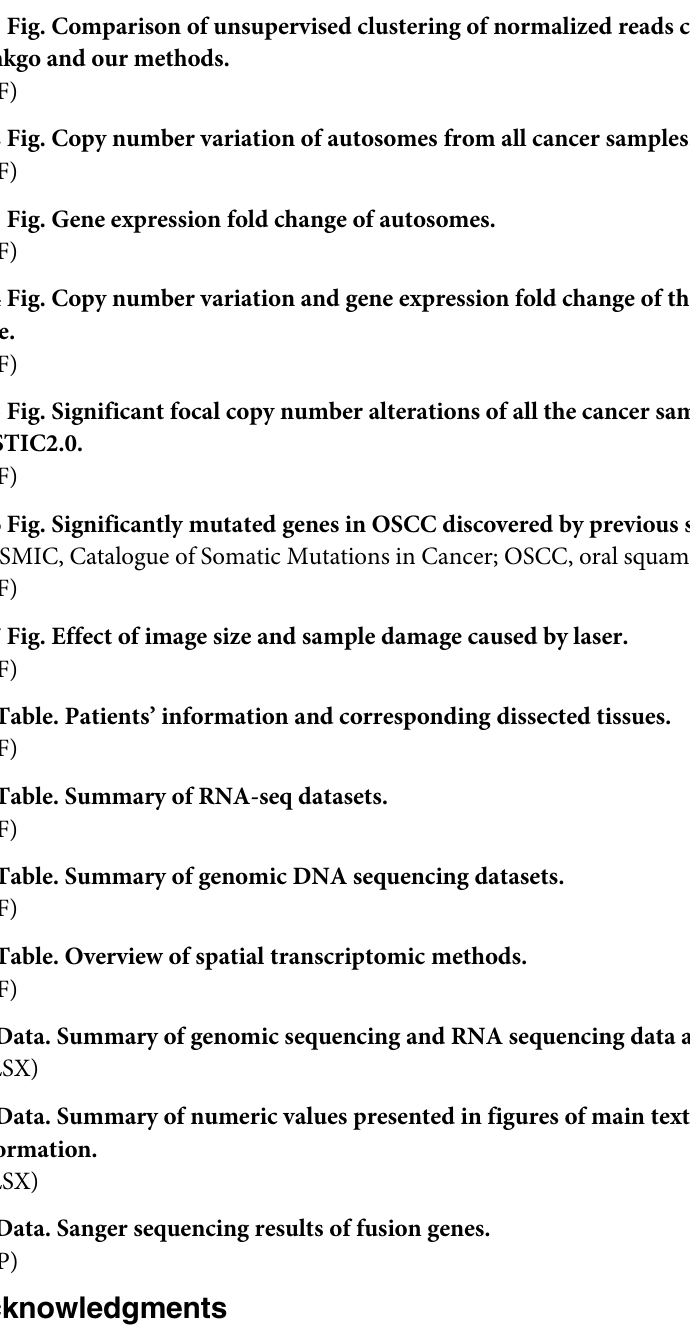
S20 Fig. Genome-wide copy number distribution at different sampling rates. (TIF) S21 Fig. Comparison of unsupervised clustering of normalized reads count between Ginkgo and our methods. (TIF) S22 Fig. Copy number variation of autosomes from all cancer samples. (TIF) S23 Fig. Gene expression fold change of autosomes. (TIF) S24 Fig. Copy number variation and gene expression fold change of the same sectioned slice. (TIF) S25 Fig. Significant focal copy number alterations of all the cancer samples analyzed by GISTIC2.0. (TIF) S26 Fig. Significantly mutated genes in OSCC discovered by previous study and COSMIC. COSMIC, Catalogue of Somatic Mutations in Cancer; OSCC, oral squamous cell carcinoma. (TIF) S27 Fig. Effect of image size and sample damage caused by laser. (TIF) S1 Table. Patients’ information and corresponding dissected tissues. (TIF) S2 Table. Summary of RNA-seq datasets. (TIF) S3 Table. Summary of genomic DNA sequencing datasets. (TIF) S4 Table. Overview of spatial transcriptomic methods. (TIF) S1 Data. Summary of genomic sequencing and RNA sequencing data analysis. (XLSX) S2 Data. Summary of numeric values presented in figures of main text and supporting information. (XLSX) S3 Data. Sanger sequencing results of fusion genes.